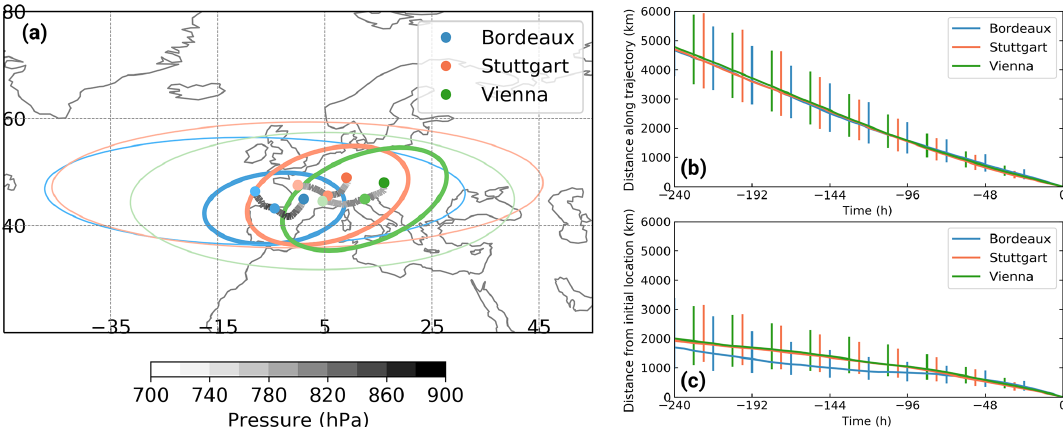
Figure 9. A 10d backward trajectory analysis from 22 May to 12 June 2018. (a) Median backward trajectories coloured by their median pressure (hPa) for three locations are given in the legend. The ellipses show the dispersion of the trajectories around their median location (dots) at 10d (thin ellipses) and 5d (bold ellipses) prior to arriving at the location. The dimensions of the ellipses are given by the eigenvalues of the covariance matrix of all longitude–latitudes at the respective times and the ellipses are rotated such that their semi-major axes align with the largest eigenvector. The length of the semi-major and semi-minor axes are chosen such that the ellipses enclose about two-thirds of the trajectories. (b) Temporal evolution of median distance travelled by the trajectories (km) prior to arriving at one of the locations given in the legend. Bars show the interquartile range. (c) As in panel (b) but for distance from the initial